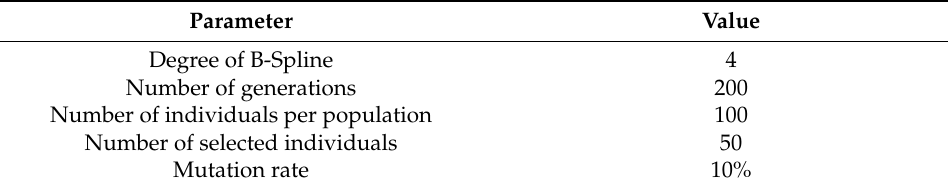
Table 6. Paramters of B-Spline path planner with GA optimization.